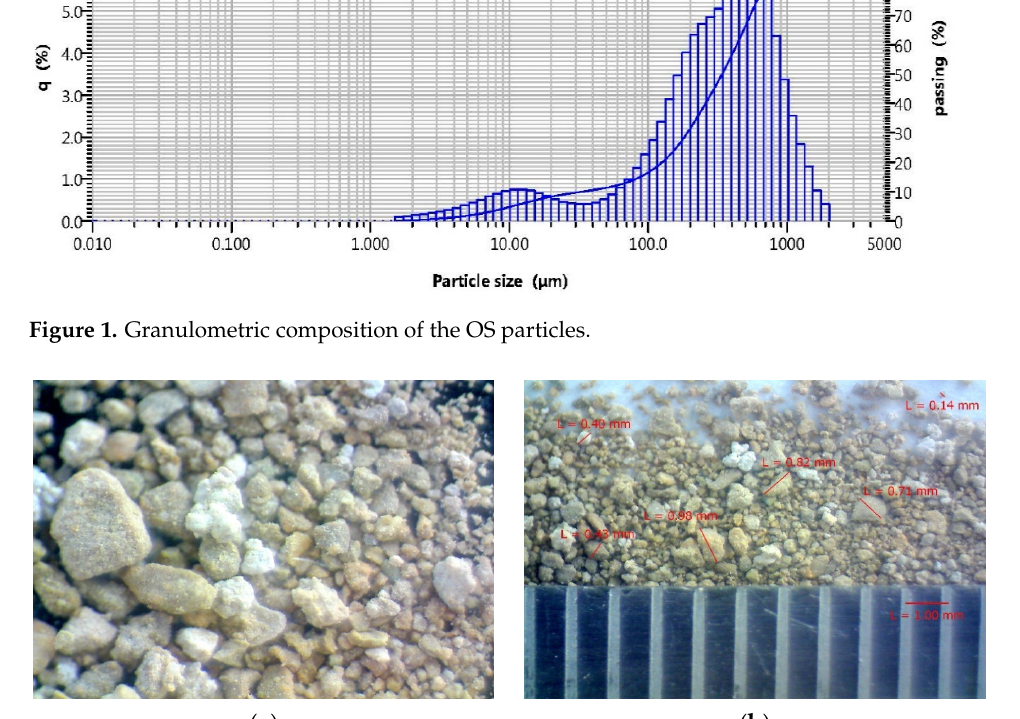
Figure 1. Granulometric composition of the OS particles.